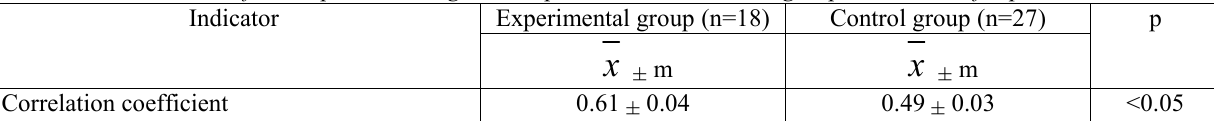
Mean values of correspondence degree in experimental and control groups at the end of